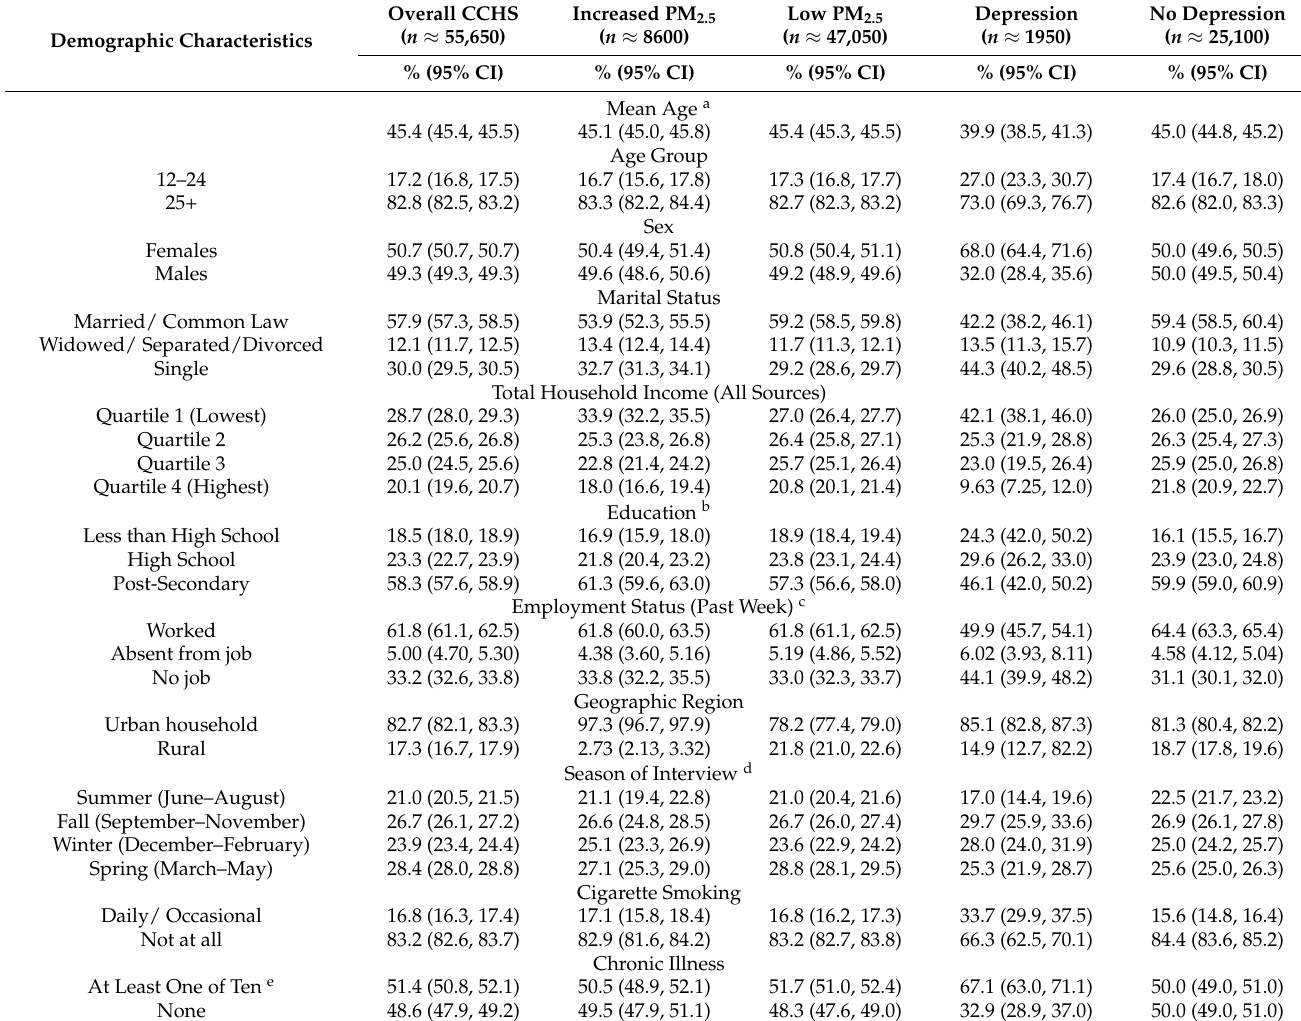
Table 1. 2016 descriptive